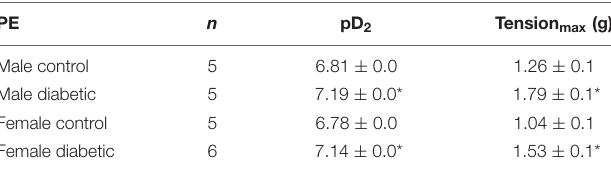
TABLE 4 | pD 2 and Tension max to phenylephrine (PE) in aortic rings from male and female control and diabetic rats. PE n pD 2 Tension max (g)